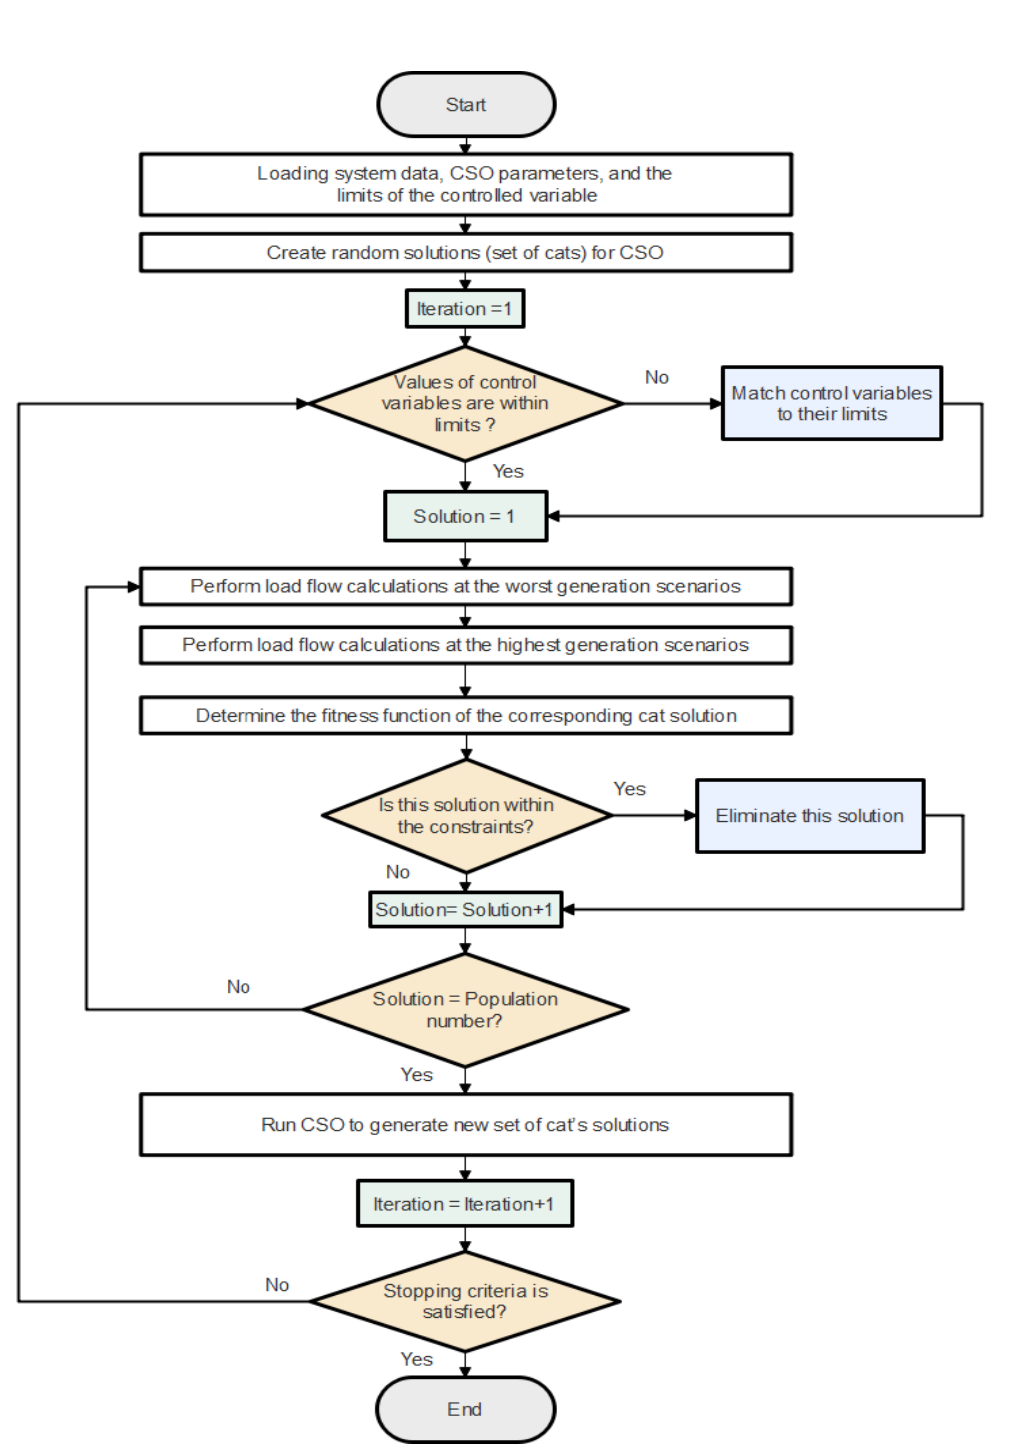
Figure 7. Flowchart of each stage in the proposed algorithm.